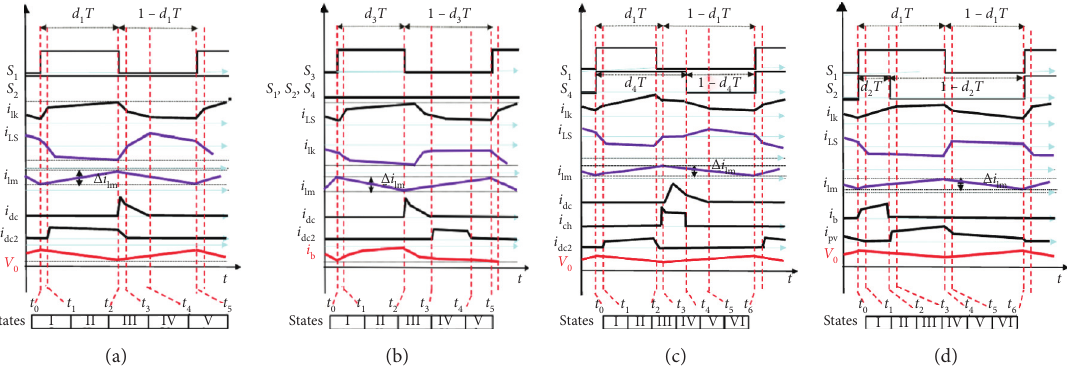
Figure 2: Steady-state theoretical waveform. (a) SISO mode (boost operation). (b) SISO mode (buck operation). (c) DISO mode. (d) SIDO mode.